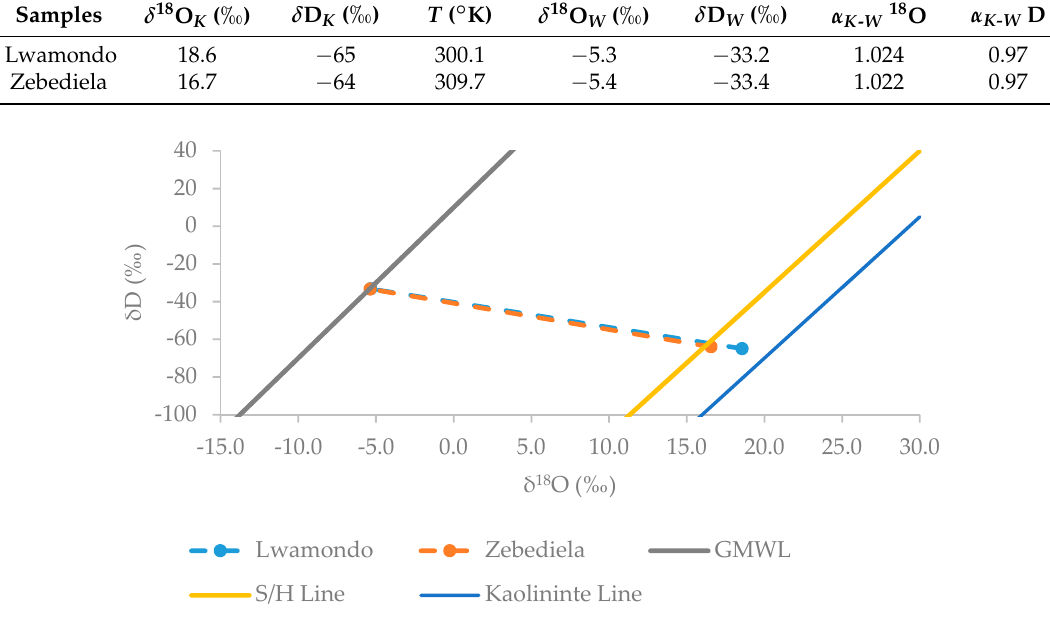
Figure 13. δ 18 O vs. δ D diagram for <2 µ m fraction of the Lwamondo and Zebediela kaolins. The GMWL, S/H Line and kaolinite lines are given as reference.